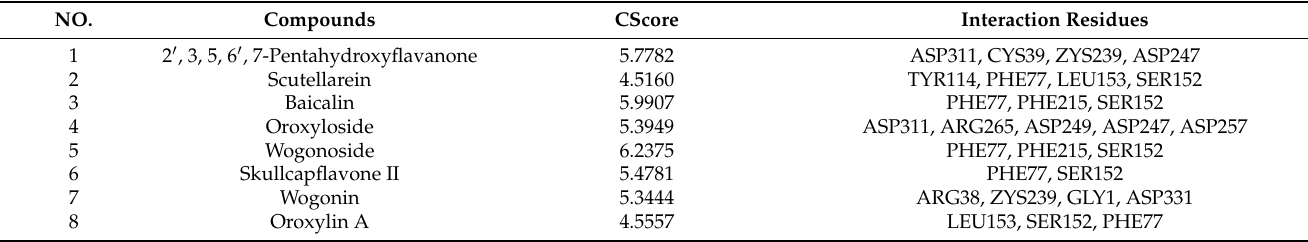
Table 2. The results of docking analysis of 8 compounds obtained by ligand